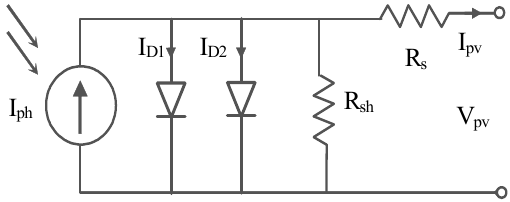
Figure 2. Equivalent circuit of a double-diode solar cell model.